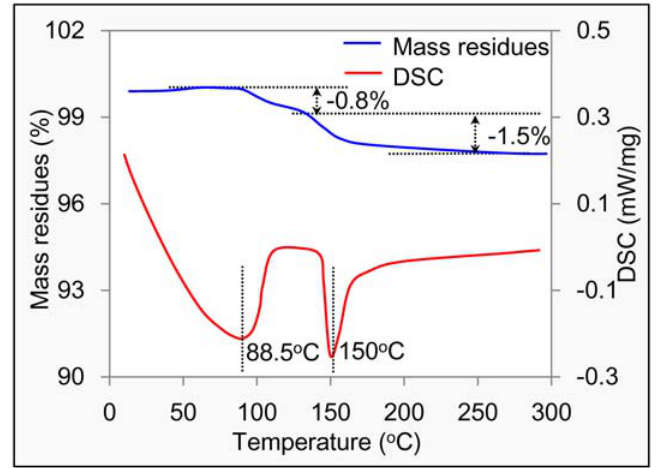
Figure 10. TG-DSC analysis result of DGR.